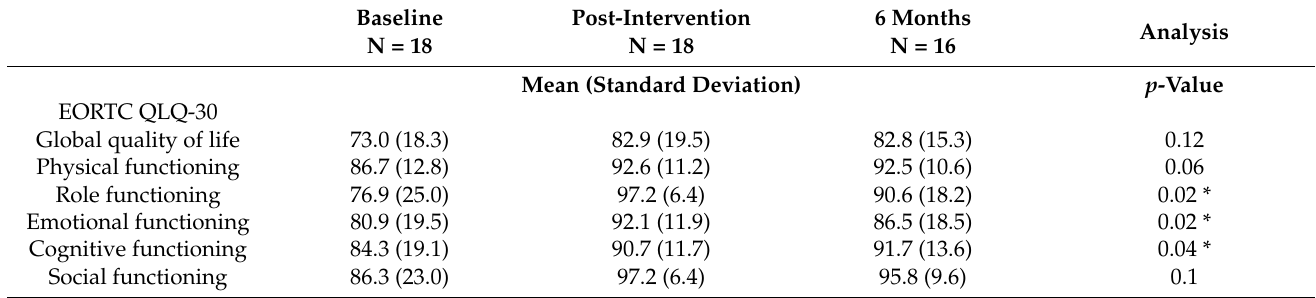
Table 3. Quality of life outcomes over time.